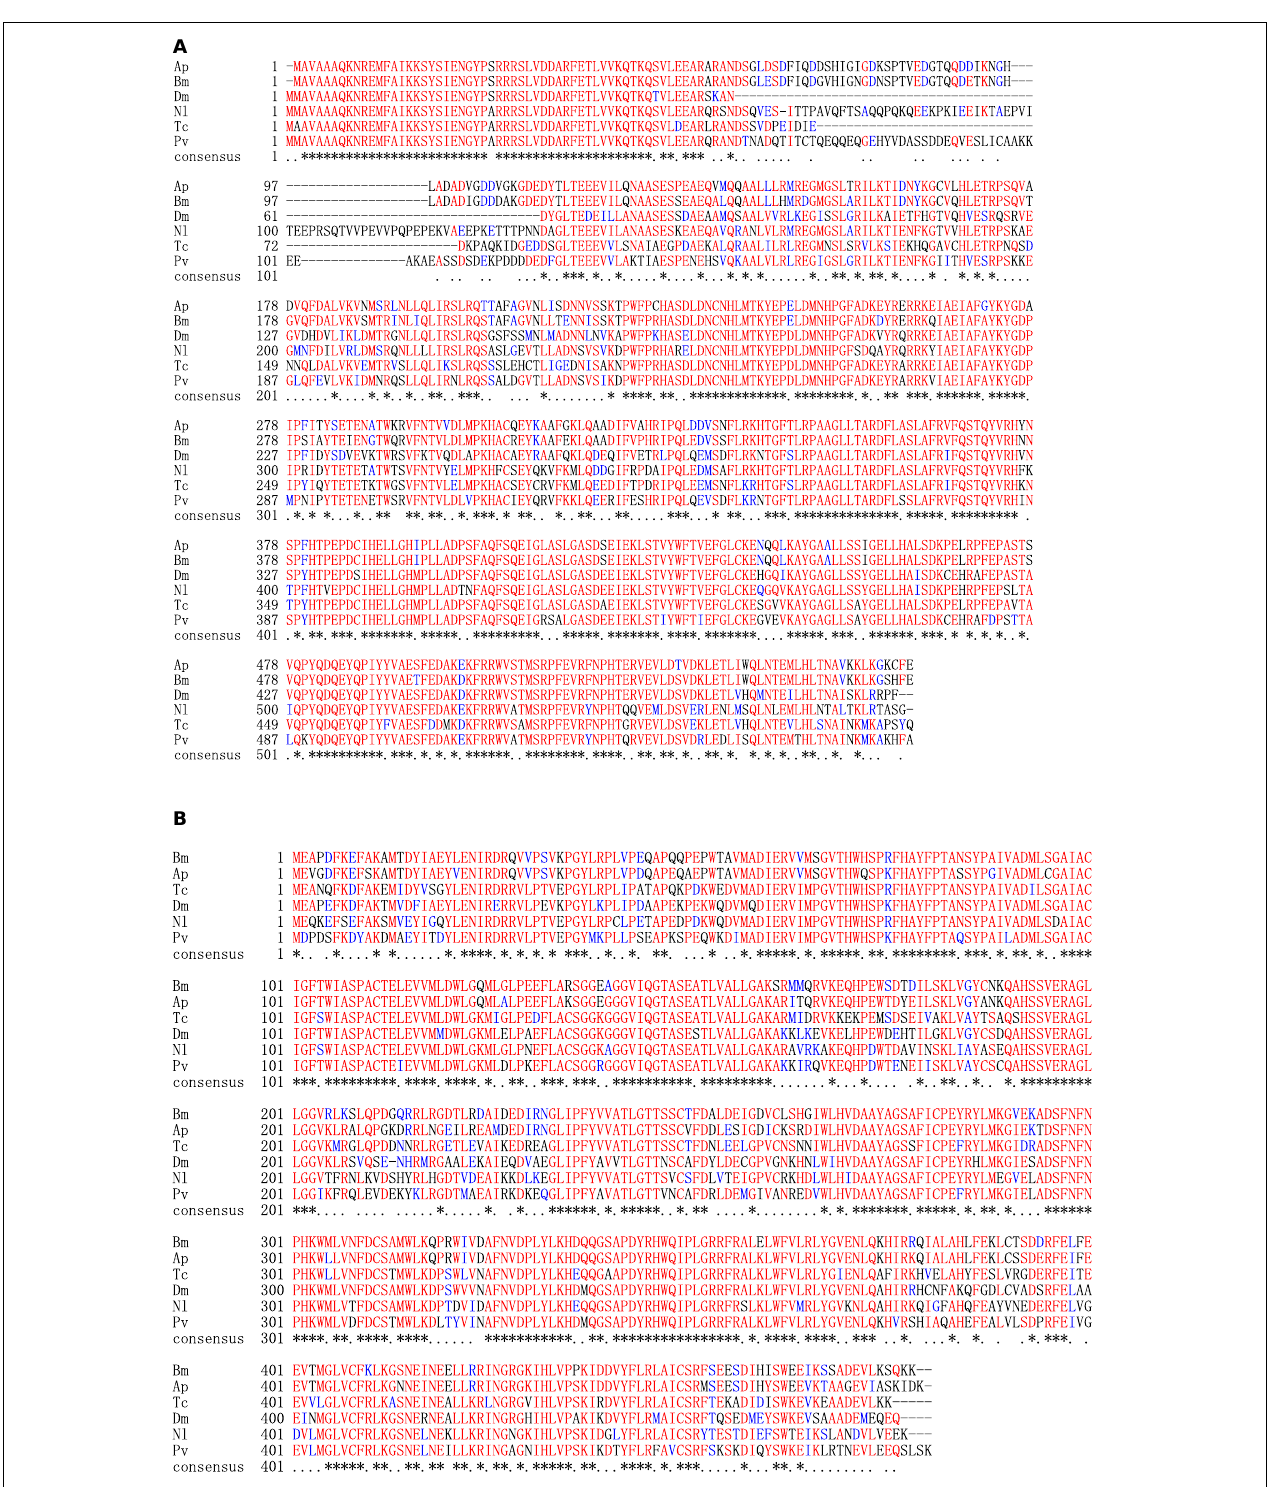
FIGURE 2 | Alignment of deduced amino acid sequences of TH (A) and DDC (B) . Amino acids with identical and similar residues are marked with asterisks and dots. Species abbreviations and accession nos. of the sequences used in the alignment are BmTH -Bombyx mori (NP_001138794.1), PvTH -Polyrhachis vicina (AEC14314.1), TcTH -Tribolium castaneum (NP_001092299.1), NlTH -Nilaparvata lugens (QEE04288.1), DmTH -Drosophila melanogaster (CAA53802.1), ApTH- Antheraea pernyi (QZU75311.1); BmDDC -B. mori (AAK48988.1), TcDDC -T. castaneum (ABU25222.1), DmDDC- D. melanogaster (NP_523600.5), NlDDC -N. lugens (QEE04289.1), PvDDC -P. vicina (AFI80897.1), ApDDC- A. pernyi (QZU75312.1).